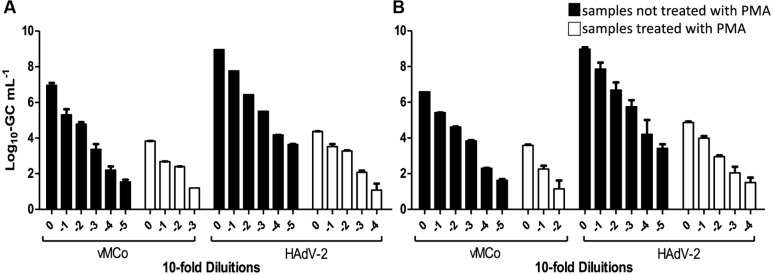
Detection of thermally inactivated vMCo and HAdV-2 with and without PMA treatment in
(A) clam and (B) “chorizo” samples. White and black bars represent whether the samples were treated or not with PMA, respectively.